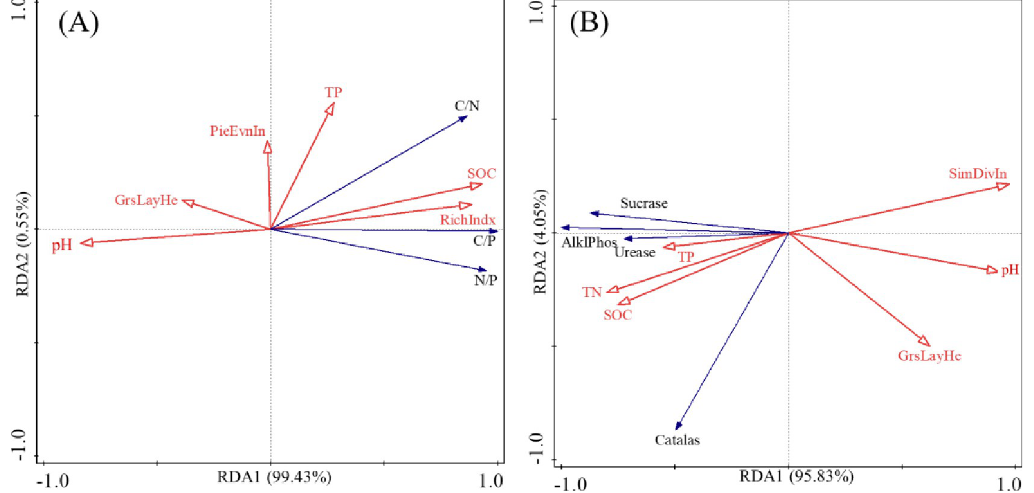
The correlations between soil stoichiometric, enzyme activity and environmental factors are shown in Table 3. There were significantly correlations between C/N and total coverage, Shan- non-Weiner, Simpson diversity, Richness, pH, SOC, TN ( P < 0.05). There were significantly correlations between C/P and Shannon-Weiner, Richness, pH, SOC, TN ( P < 0.05). There were significantly correlations between N/P and Shannon-Weiner, Richness, pH, SOC, TN ( P < 0.05). There were significantly correlations between Alkaline phosphatase and total cov- erage, Shannon-Weiner, Simpson diversity, Richness, pH, SOC, TN ( P < 0.05). There was sig- nificantly correlations between Catalase and total coverage ( P < 0.05). RDA analysis was carried out on the environmental factors and soil soil stoichiometric, enzyme activity in Fig 4.